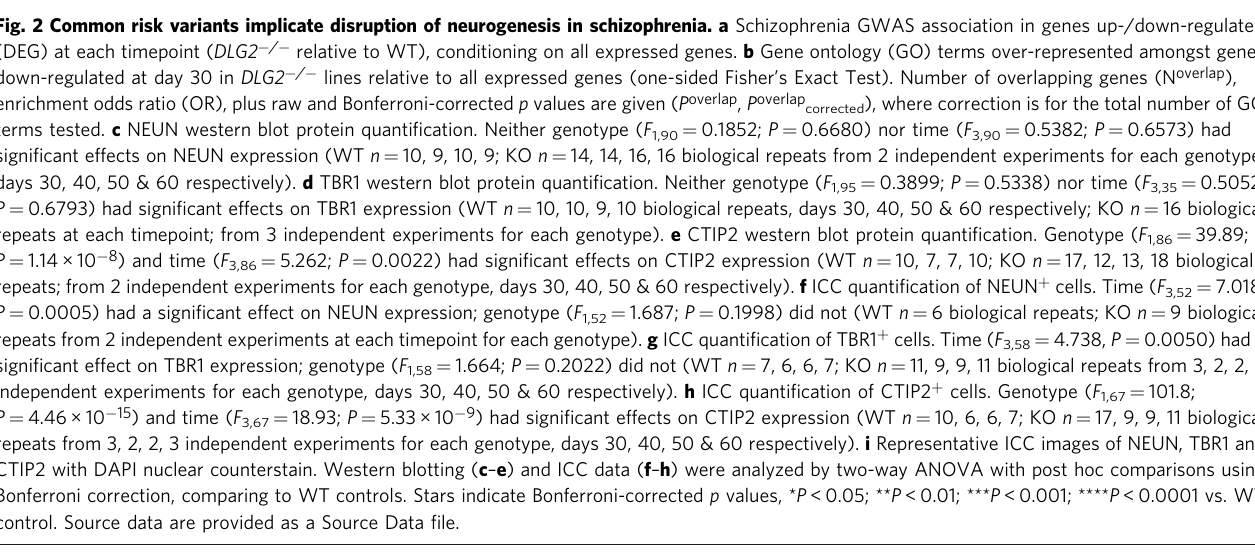
Bonferroni correction, comparing to WT controls. Stars indicate Bonferroni-corrected p values, * P < 0.05; ** P < 0.01; *** P < 0.001; **** P < 0.0001 vs. WT control. Source data are provided as a Source Data fi